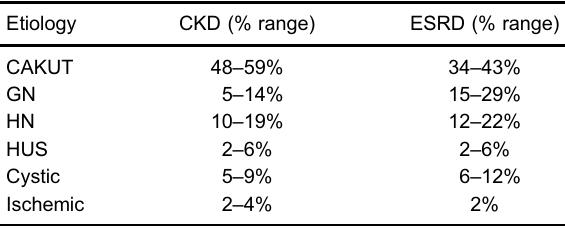
Table 2. Etiology of chronic kidney disease in children*